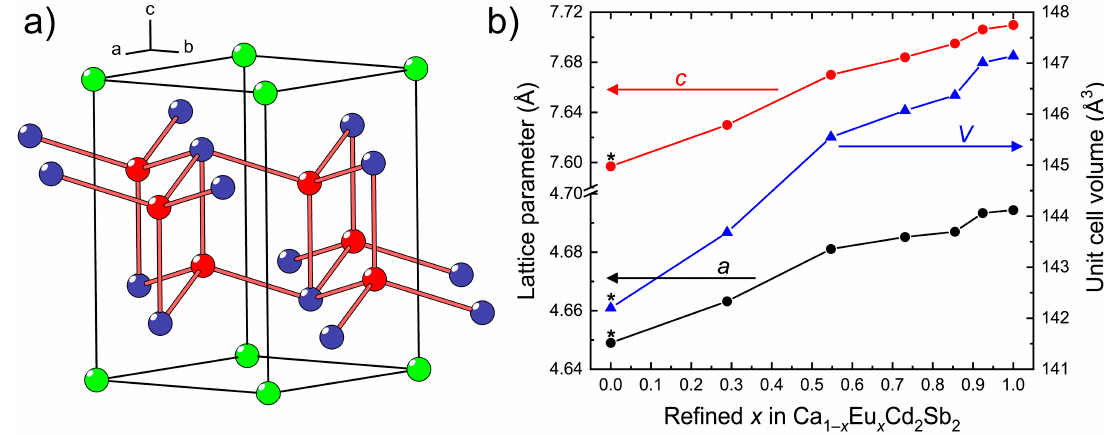
Figure 1. ( a ) Crystal structure of the CaAl 2 Si 2 -type Ca 1 − x Eu x Cd 2 Sb 2 solid solution. The Ca/Eu, Cd, and Sb atoms are shown in green, red, and blue, respectively; ( b ) variation of the lattice parameters and unit cell volume of Ca 1 − x Eu x Cd 2 Sb 2 as a function of the Eu content. The lattice parameters of the end members, i.e., the ternary phases CaCd 2 Sb 2 and EuCd 2 Sb 2 , are included in the plot, but comparing the metrics, it must be born in mind that the literature data for CaCd 2 Sb 2 (marked with asterisks) are from room temperature [26] and that the sample is prepared via a different synthetic route. The parameters for EuCd 2 Sb 2 are from own data (CSD 1875197), whereby the crystal has been grown the same way as Ca 1 − x Eu x Cd 2 Sb 2 .